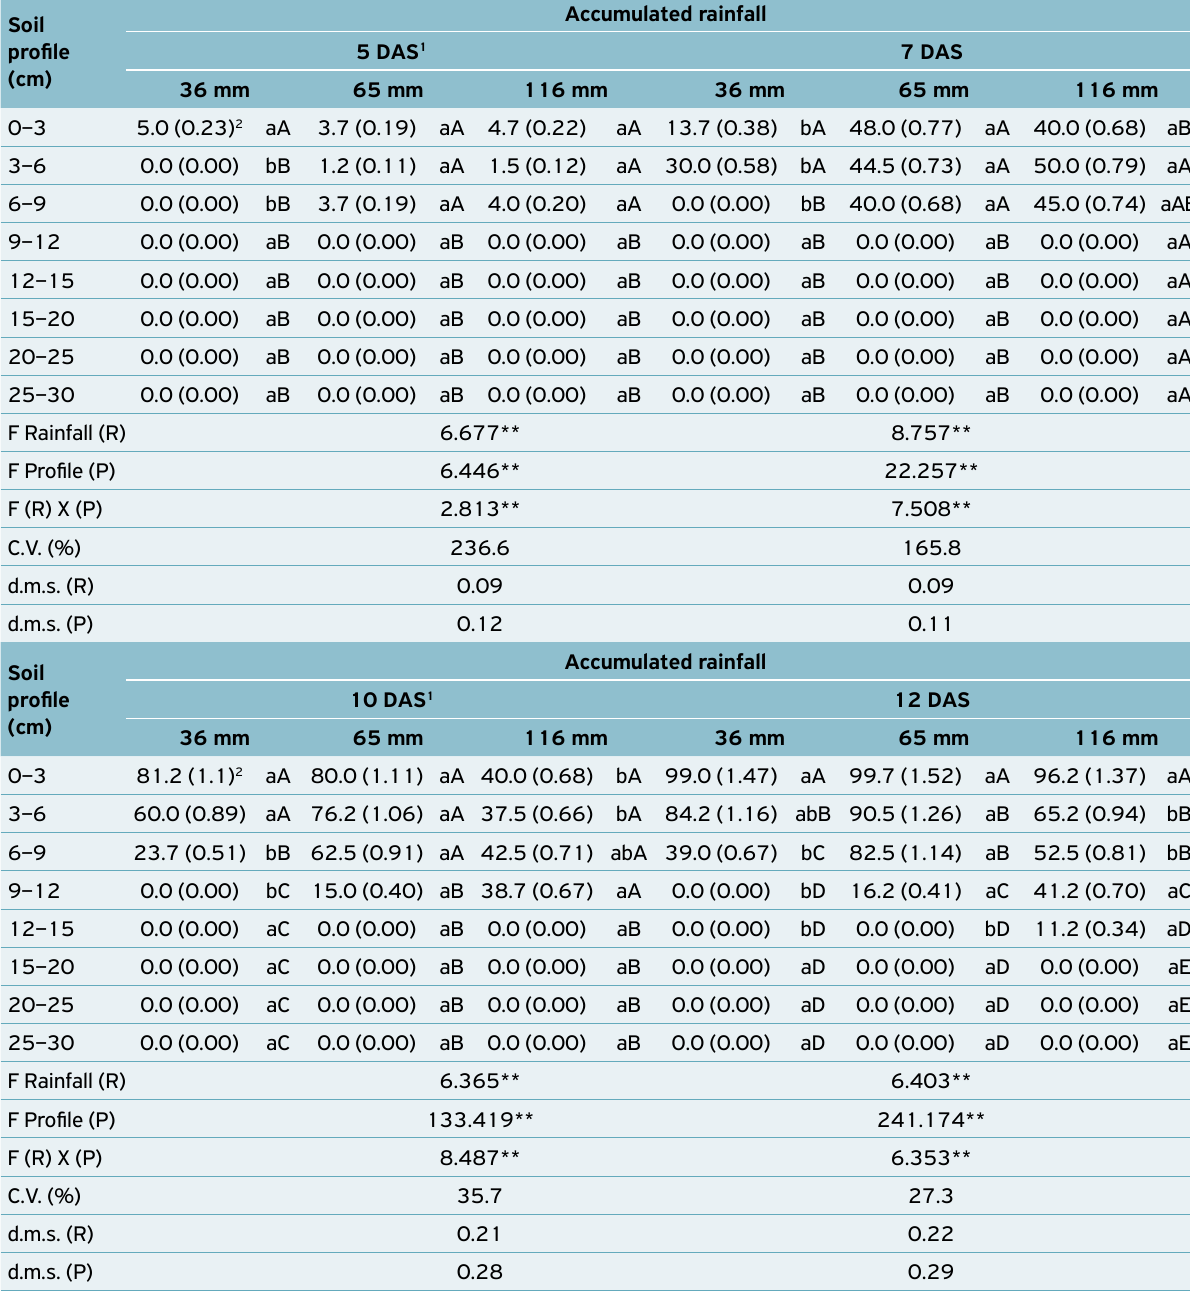
Table 5. Phytotoxicity percentage in cucumber plants after the application of tebuthiuron to a medium sandy-textured soil under different rainfall amounts. Botucatu, São Paulo,